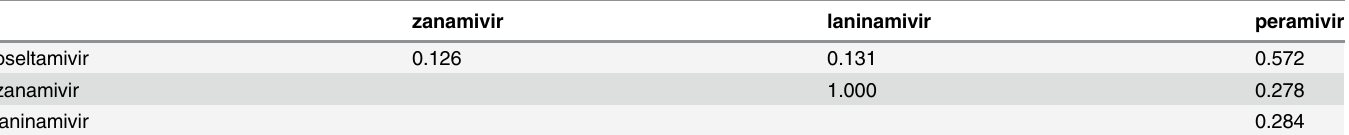
Table 2. Results of Fisher ’ s exact tests for incidence rates of the most severe abnormal behavior among types of NI during 2010/2011 through 2013/2014 season ( p